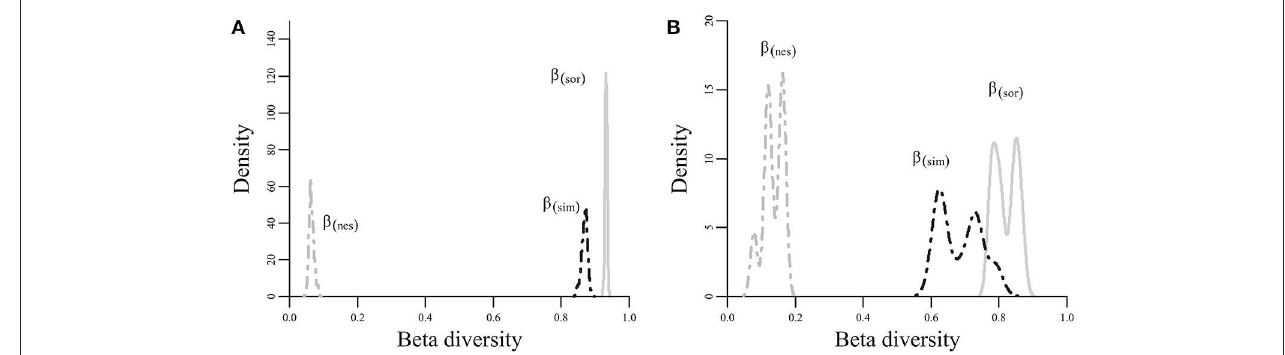
FIGURE 2 | Density plots with the distribution of general beta diversity ( β sor, solid line) and its nestedness component ( β nes, dashed gray line) and turnover component ( β sim, dashed black line). (A) Results for all sampling sites and (B) results for headwater stream sites only.